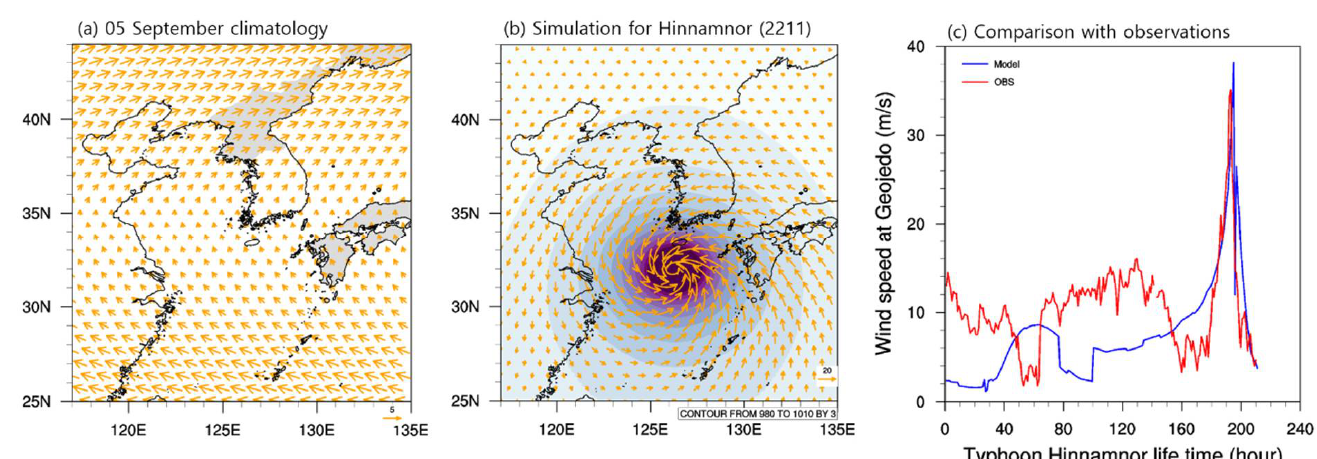
Figure 4. ( a ) Daily climatological mean surface wind, ( b ) T-P model simulation for Hinnamnor (snapshot on 5 September). The reference vector shows 5 m/s in ( a ) and 20 m/s in ( b ). Wind speed simulation (blue line) and in situ observations (red line) at Geojedo are shown in ( c ). As an implication of the parametric typhoon model results, the simulated pressure and wind data were prescribed as input data for the storm surge model simulation [19,34].